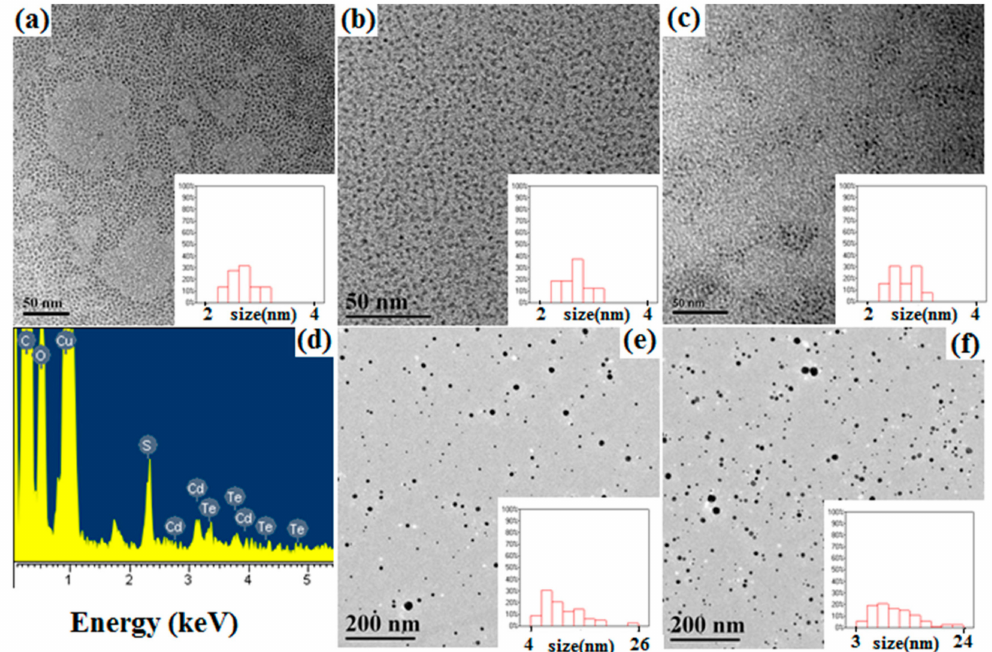
Figure 8. TEM images of ( a ) aqueous CdTe QDs, ( b ) CdTe QDs encapsulated by HPAMAM–DA in a chloroform phase, ( c ) released CdTe QDs in the form of CdTe / HPAMAM nanocomposites, ( e ) Au NPs encapsulated by HPAMAM–DA in a chloroform phase, and ( f ) released Au NPs in an aqueous phase in the form of Au / HPAMAM nanocomposites. Insets show the size distributions of CdTe QDs or Au NPs. ( d ) EDS spectrum of released CdTe QDs in the form of CdTe / HPAMAM